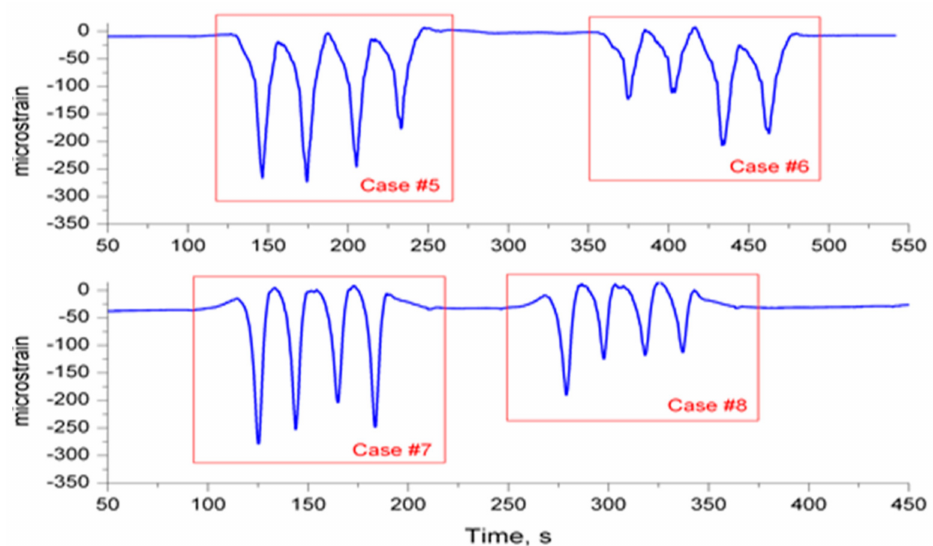
Figure 14. Cases #5 to #8 of non-uniform strain distribution in the ring girder of a tested bucket-wheel excavator. Strain values are given in